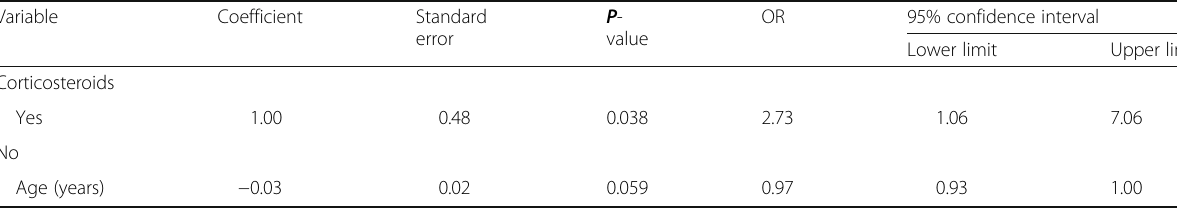
Table 3 Multivariate analysis of risk factors for methotrexate intolerance Variable